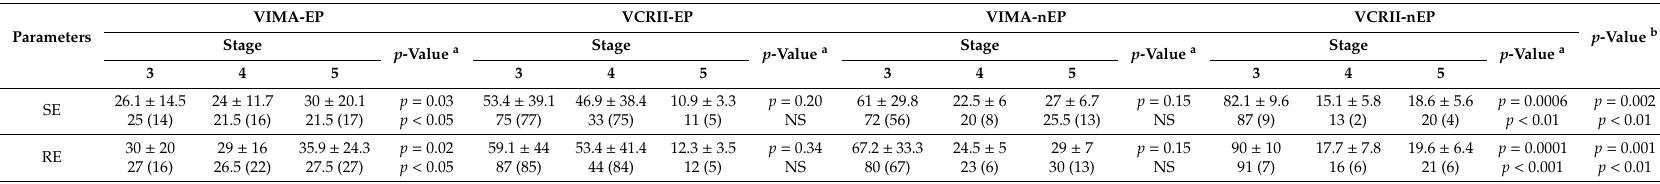
Table 2. Comparison of values of monitored patients’ parameters between di ff erent stages of volatile induction of general anaesthesia in studied groups of patients.